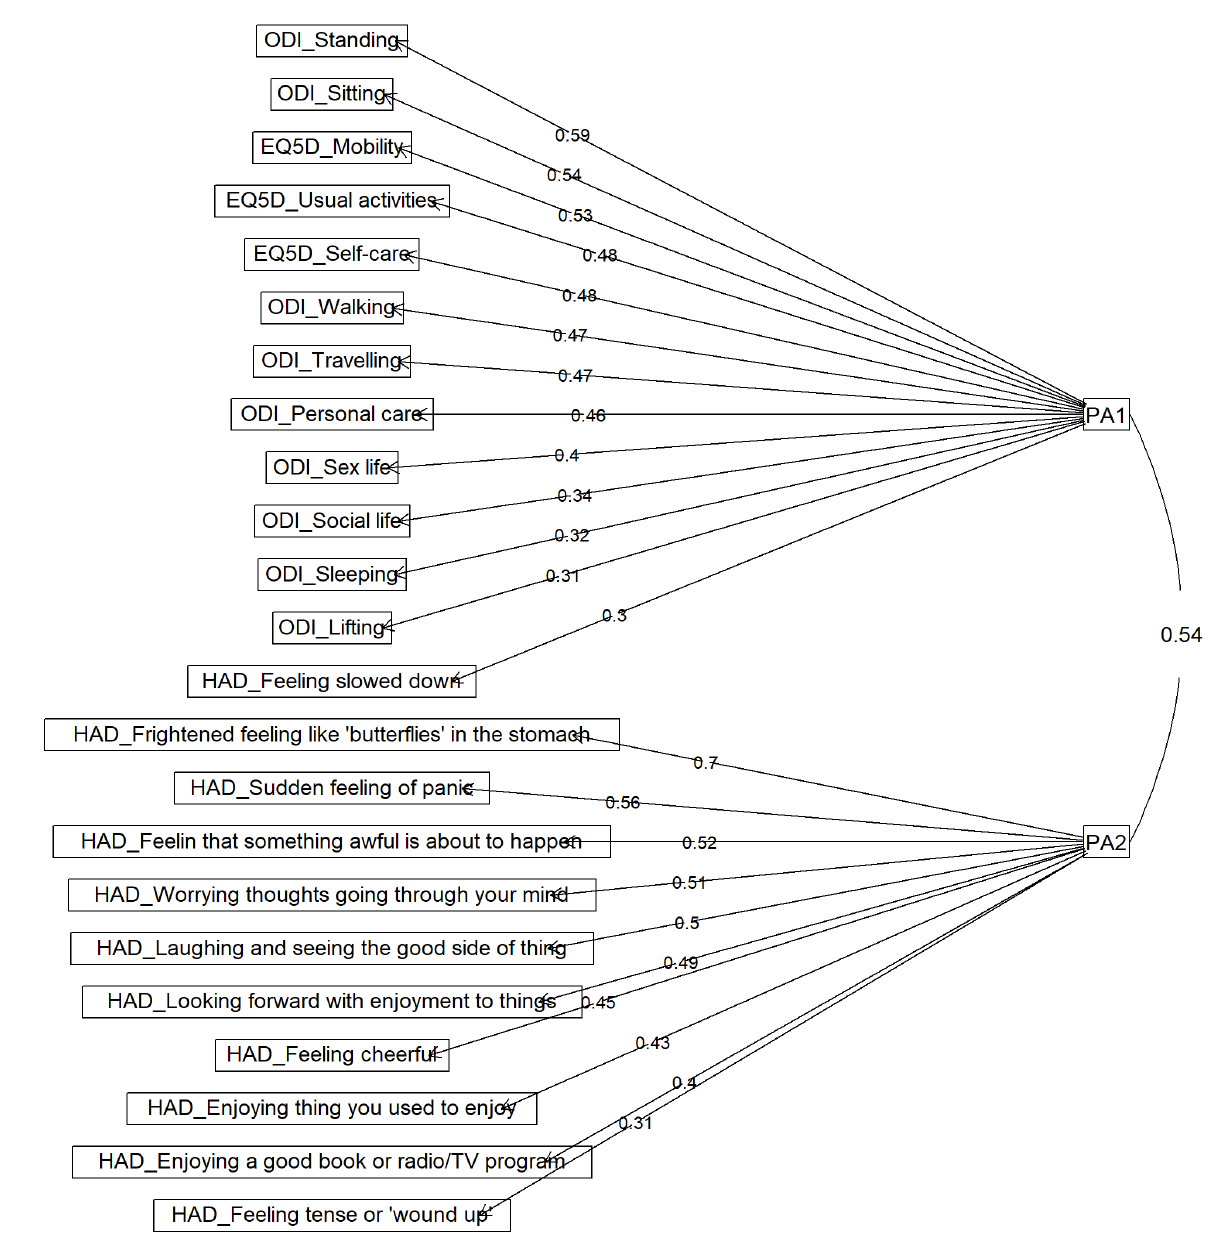
Figure 2. The EFA results with a promax rotation and principal axis factor extraction. (PA1) is the factor associated with functional disability and PA2 is the factor associated with depression/anxiety (PA2). EQ-5D: EuroQol-5 Dimensions; ODI: Oswestry Disability Index; HAD: Hospital Anxiety and Depression.